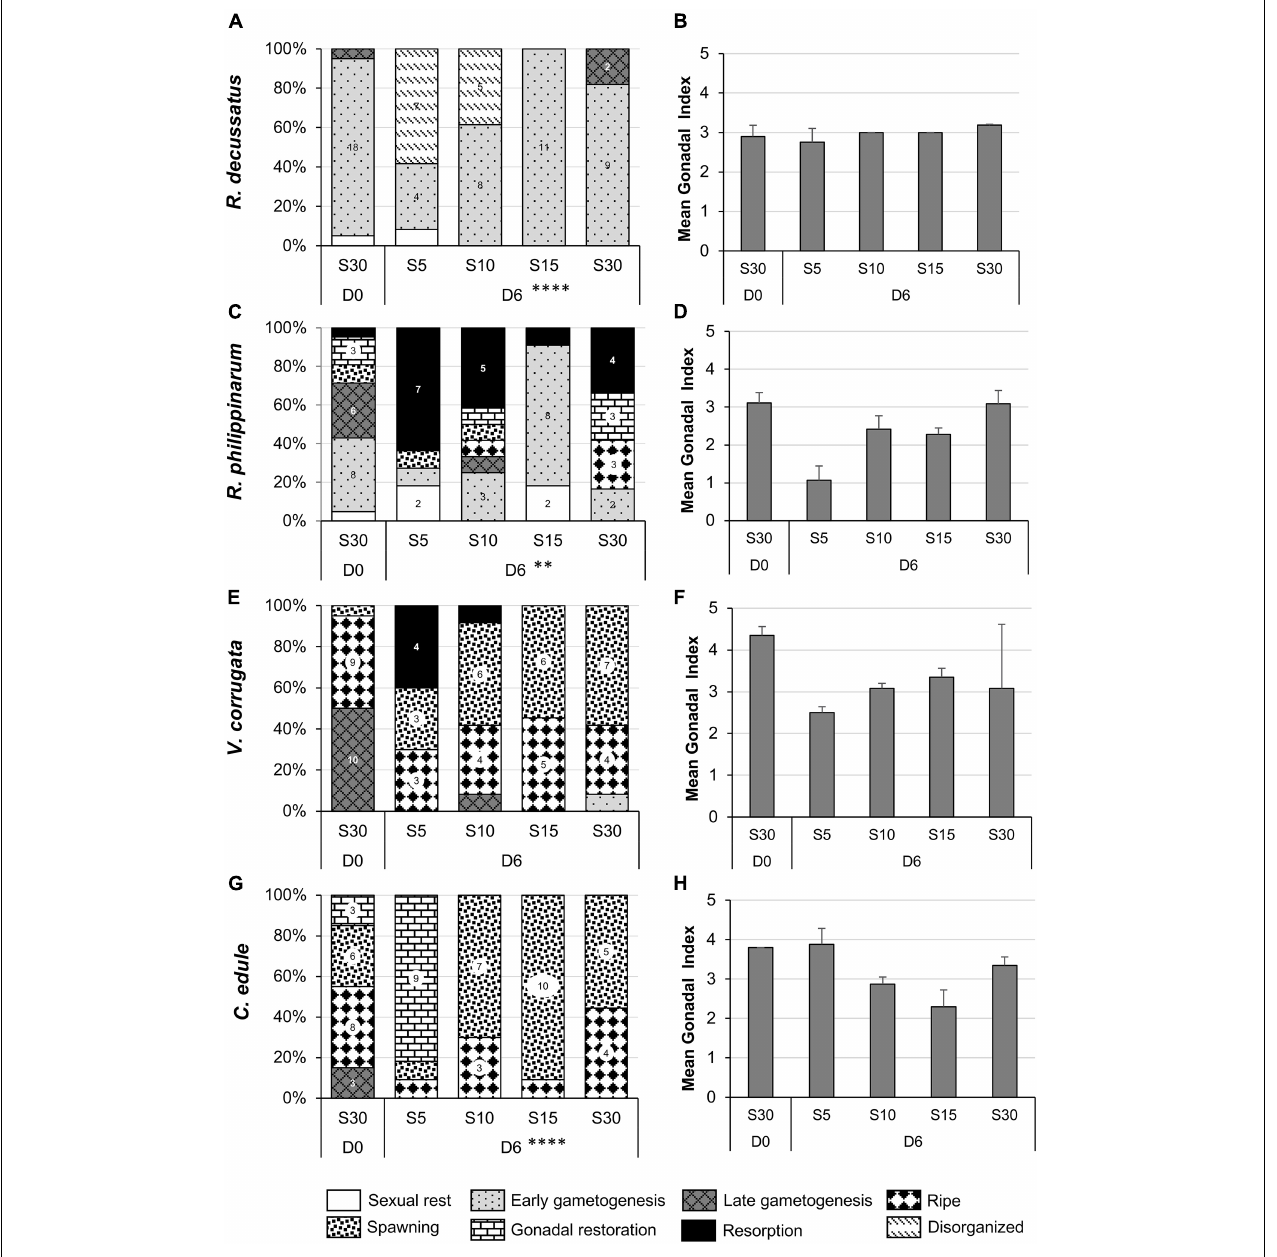
FIGURE 5 | Gonadal stages (percentage) (A,C,E,G) and gonadal index (mean + SD) (B,D,F,H) in the March low salinity experiment in each salinity treatment at the beginning of the experiment (D0) and after six days of stress (D6). Salinity treatments: S5 corresponds to a salinity ramp from 5 to 20, S10 from 10 to 25, S15 from 15 to 30, and S30 control. (A,B) Ruditapes decussatus ; (C,D) Ruditapes philippinarum ; (E,F) Venerupis corrugata ; (G,H) Cerastoderma edule . Asterisks refer to the significance of the multinomial logistic regressions: ∗∗ p < 0.01; ∗∗∗∗ p < 0.0001. Number in the bars indicate number of individual clams within categories. Categories without number but present in the graph means one